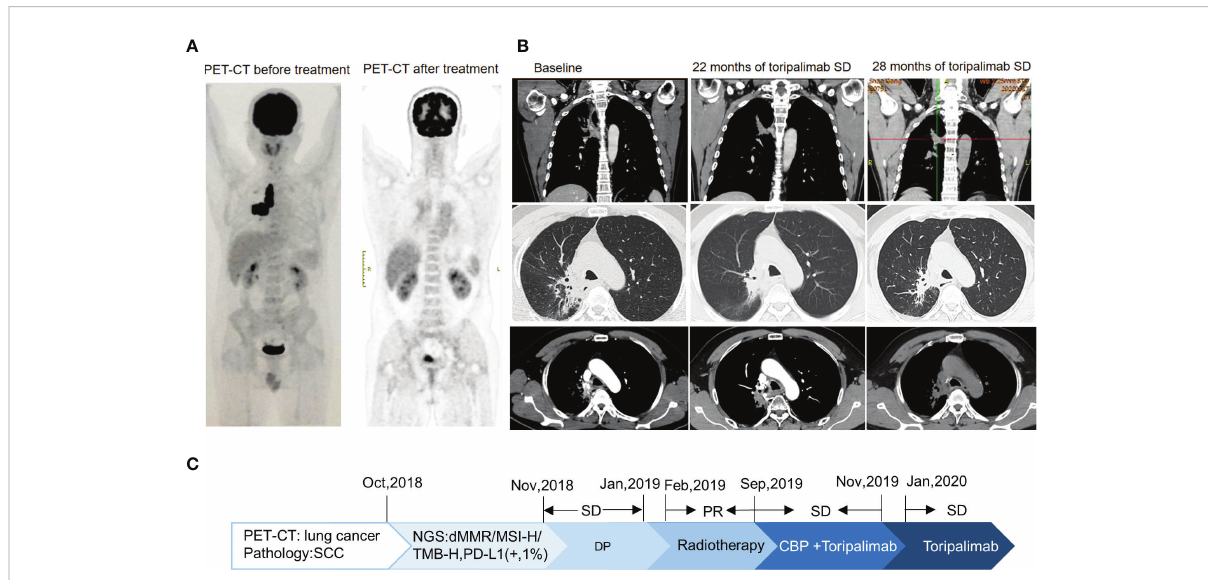
FIGURE 1 Imaging changes. (A) For PET-CT at diagnosis versus PET-CT after comprehensive treatment, the overall ef fi cacy was PR. (B) CT images of Toripalimab during the different treatment periods. (C) The timeline of the main events of this case